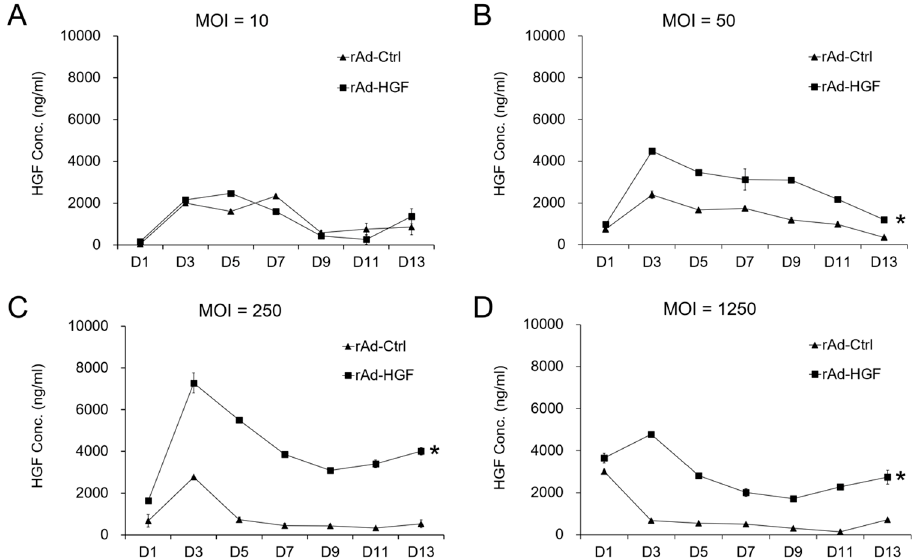
Figure 1. Secretion of HGF by hBMSCs infected with recombinant adenoviruses. Human BMSCs were cultured in the growth medium and infected with rAd-HGF or the control recombinant adenovirus rAd-Ctrl at MOI = 10 ( A ), 50 ( B ), 250 ( C ), and 1250 ( D ), and the secretory HGF level was assayed using ELISA. The results showed that rAd-HGF infection significantly promoted HGF secretion starting with MOI = 50. * p < 0.05. The experiment has been replicated three times with similar results, and the representative results were shown.